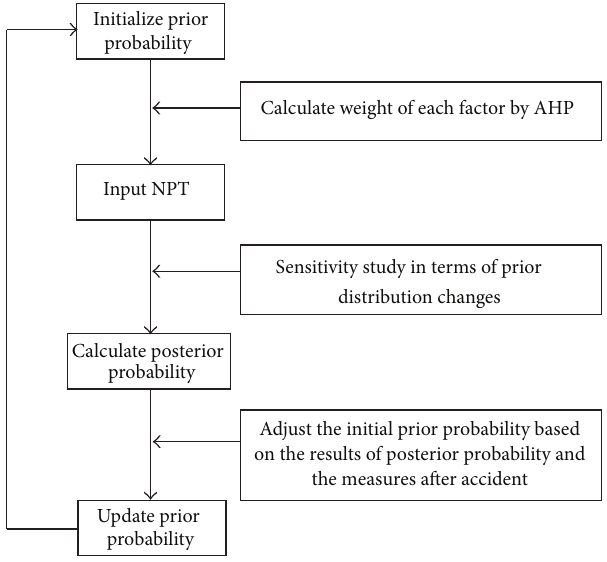
Figure 3: Framework of the BBN model supported by AHP.